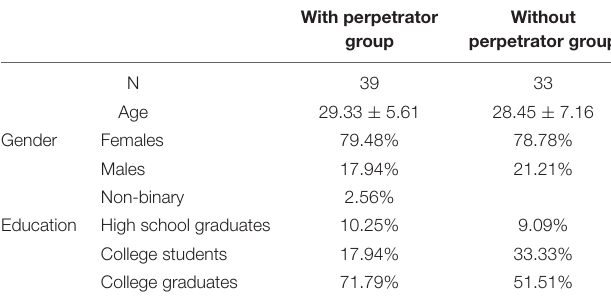
TABLE 1 | Sociodemographic